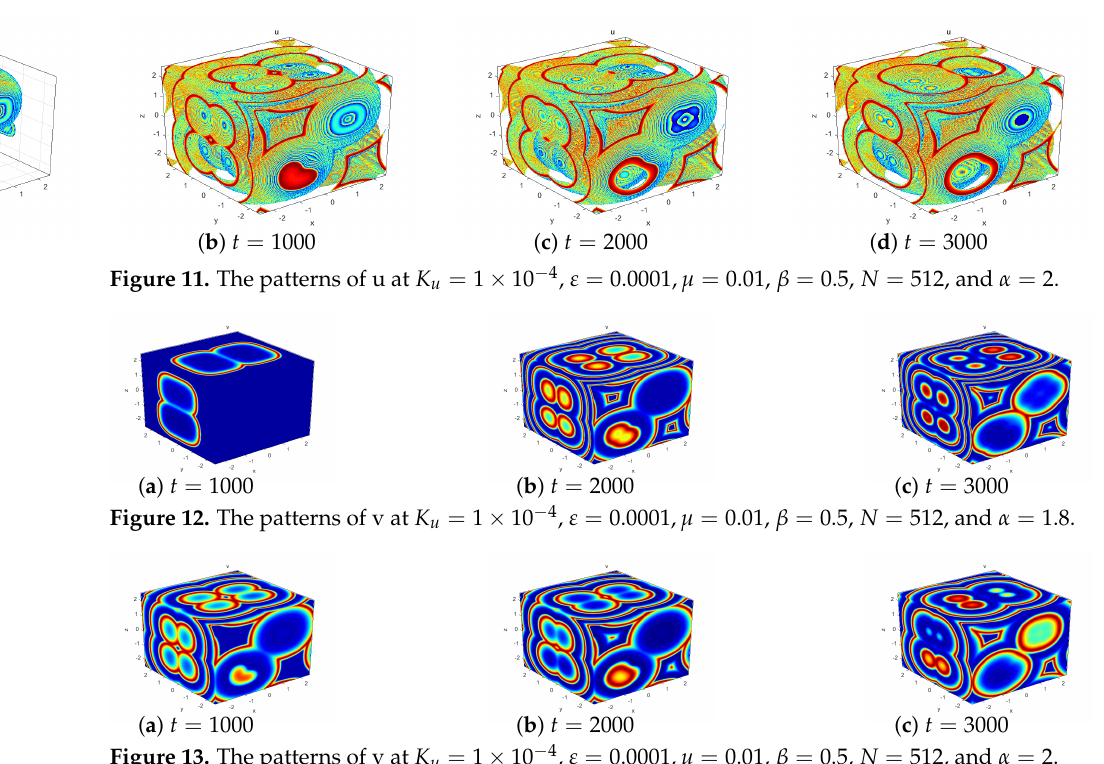
Figure 13. The patterns of v at K u = 1 × 10 − 4 , ε = 0.0001, µ = 0.01, β = 0.5, N = 512, and α =